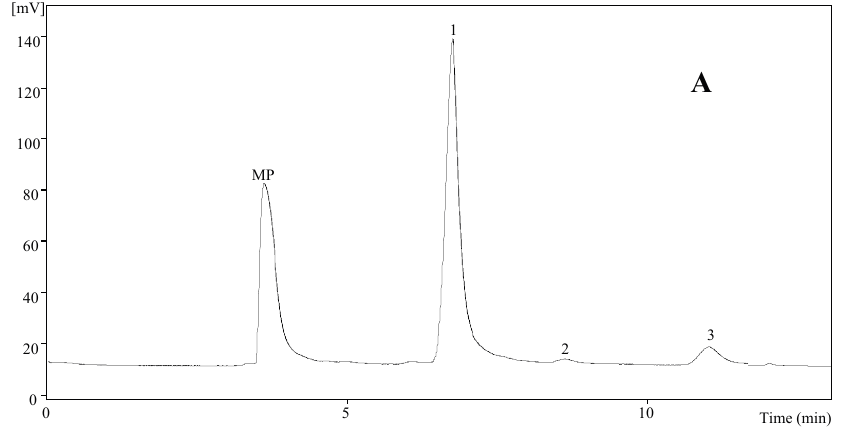
Figure 1. Individual profile in sugars ( A ) of L. turpis : 1-mannitol, 2-trehalose, 3-raffinose (IS); fatty acids ( B ) of L. citriolens : 1-caproic acid (C6:0); 2-caprylic acid (C8:0); 3-capric acid (C10:0); 4-lauric acid (C12:0); 5-myristic acid (C14:0); 6-myristoleic acid (C14:1); 7-pentadecanoic acid (C15:0); 8-palmitic acid (C16:0); 9-palmitoleic acid (C16:1); 10-heptadecanoic acid (C17:0); 11-stearic acid (C18:0); 12-oleic acid (C18:1n9c); 13-linoleic acid (C18:2n6c); 14- α -linolenic acid (C18:3n3c); 15-arachidic acid (C20:0); 16-eicosenoic acid (C20:1c); 17-cis-11,14-eicosadienoic acid (C20:2c); 18-cis-11,14,17- eicosatrienoic acid and heneicosanoic acid (C20:3n3 + C21:0); 19-cis-5,8,11,14,17- eicosapentaenoic acid (C20:5n3); 20-behenic acid (C22:0); 21-tricosanoic acid (C23:0); 22-lignoceric acid (C24:0); 23-nervonic acid (C24:1); and tocopherols ( C ) of L turpis : 1- α -tocopherol, 2-BHT, 3- β -tocopherol, 4- γ -tocopherol, 5-tocol (IS). MP-mobile